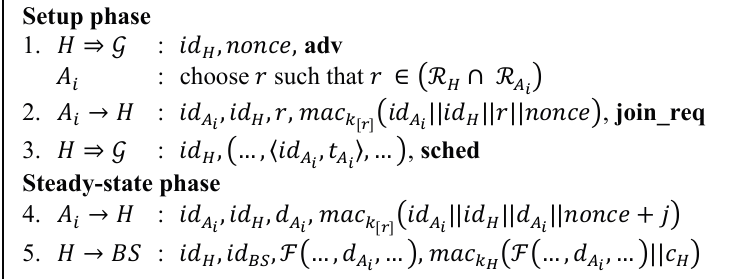
Figure 3. SecLEACH